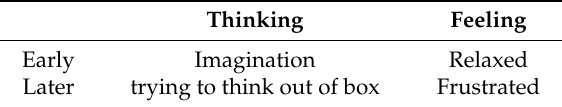
Table 4. Participant 7’s micro diary.